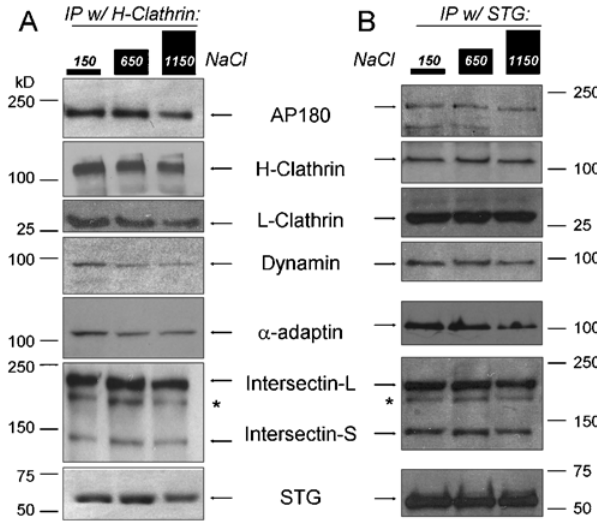
Figure 2. Endocytosis-related proteins co-precipitate from rat brain synaptosomes and co-precipitated protein recovery is ionic strength- sensitive. Proteins immunoprecipitated with H-clathrin ( leftpanel ) or STG ( rightpanel ) from rat synaptosome lysate after exposure to the three salt buffers. Each panel shows bands that correspond in molecular weight to the labeled protein recovered after the three salt treatments (see Fig.1 legend). For example, comparing the 1150 mM salt-treated to the control, 150 mM salt-treated, there was a high recovery of H- clathrin, a moderate recovery of L-clathrin or S-intersectin and a low recovery of dynamin. The asterisk denotes an intermediate intersectin proteolytic fragment, as reported previously.[31] Other details as in Figure1